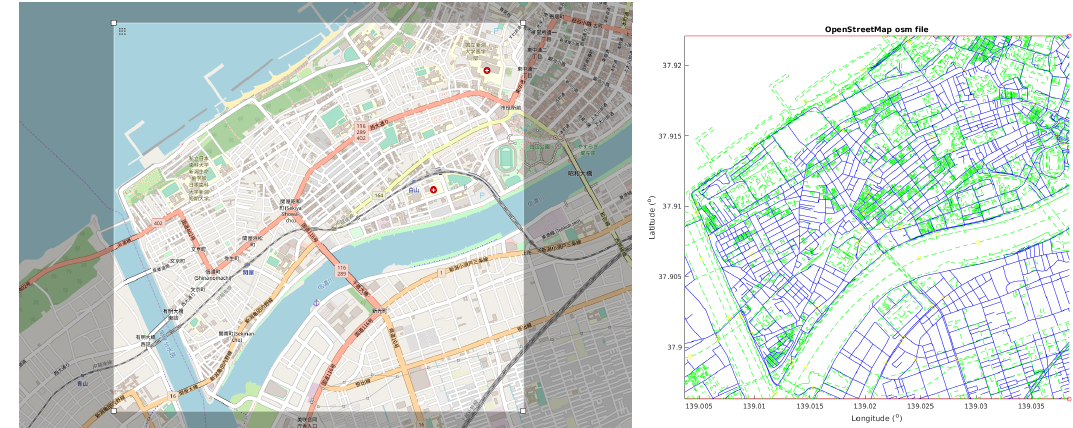
Figure 4. Left: captured region of Niigata map. Right: graph model of the map.